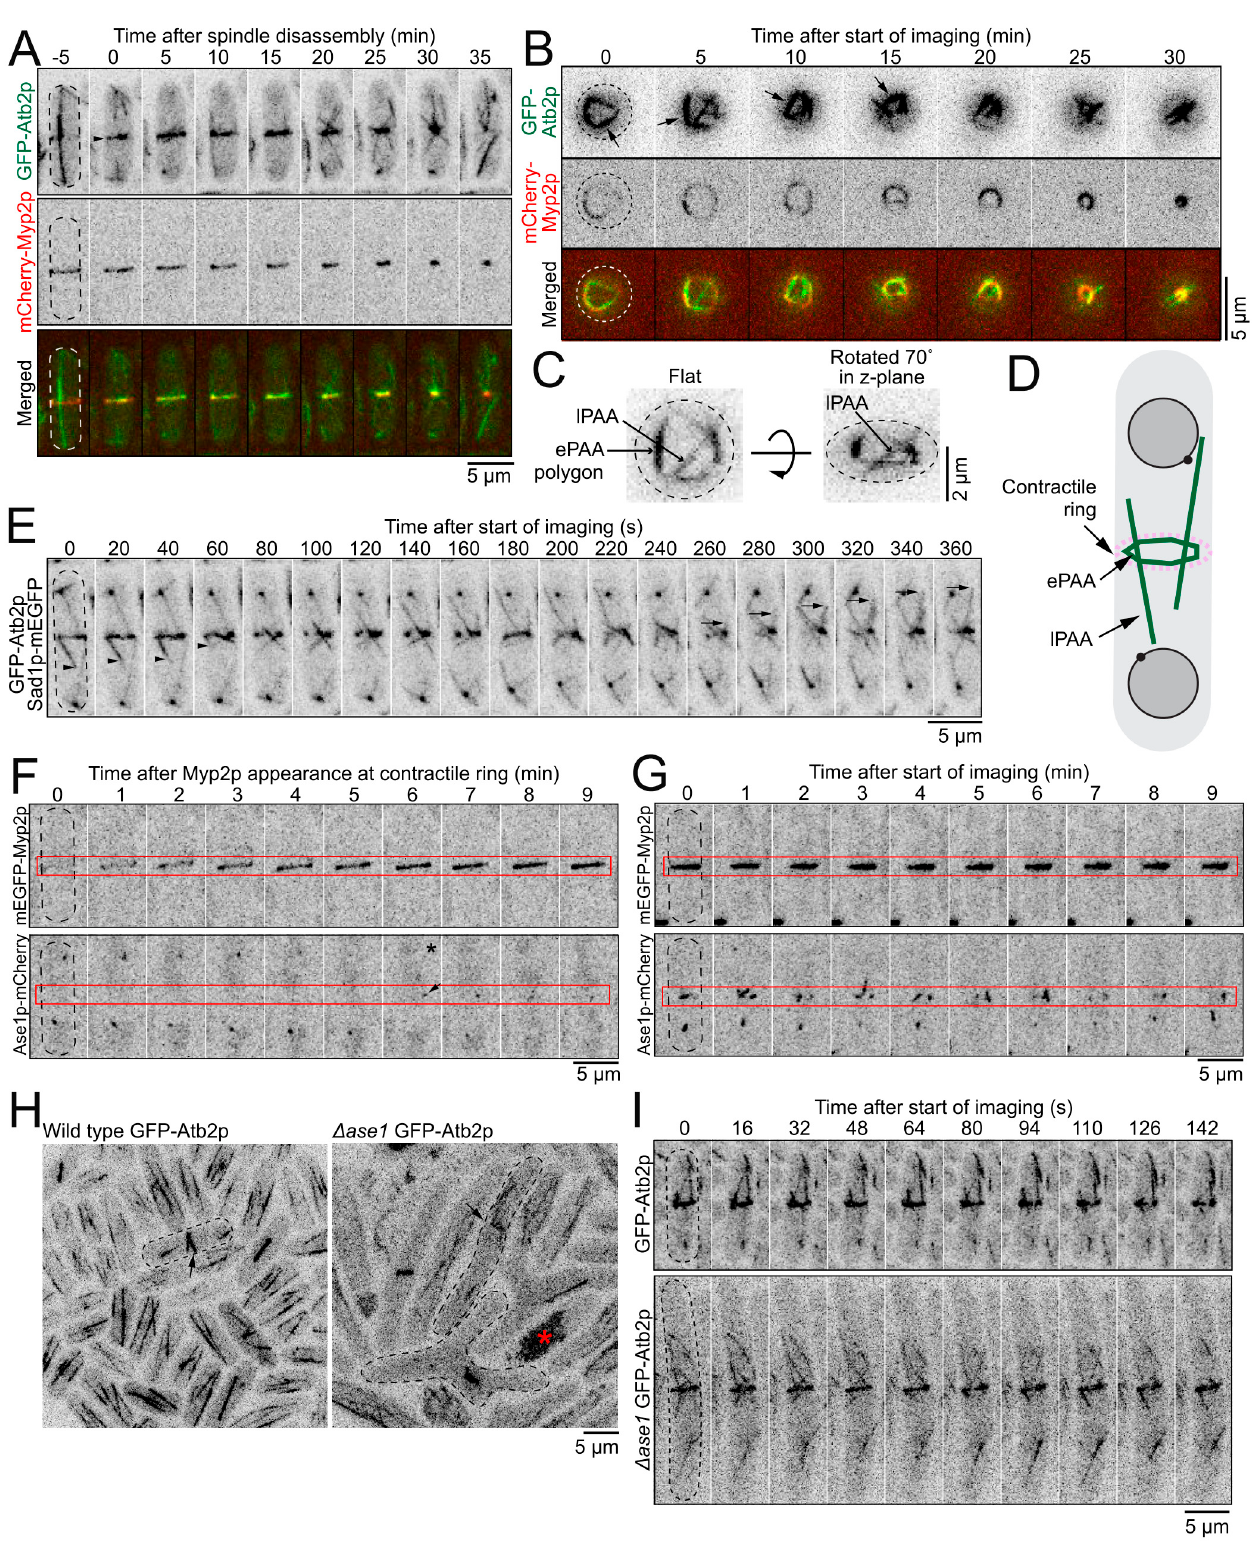
Figure 2. Polygon of ePAA microtubules bundled by Ase1p. ( A ), Timelapse micrographs of cells expressing GFP-Atb2p and mCherry-Myp2p. Arrowhead, ePAA microtubules in the plane of the contractile ring. Dashed outlines, cells. ( B ), Timelapse micrographs of a cell expressing GFP-Atb2p and mCherry-Myp2p imaged in a yeast motel. Arrows point to the equatorial PAA (ePAA) polygon